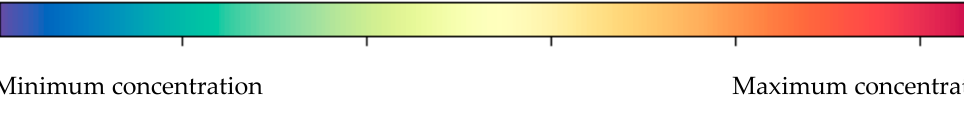
Figure 8. The concentration scale for the “openmaps” graphs.